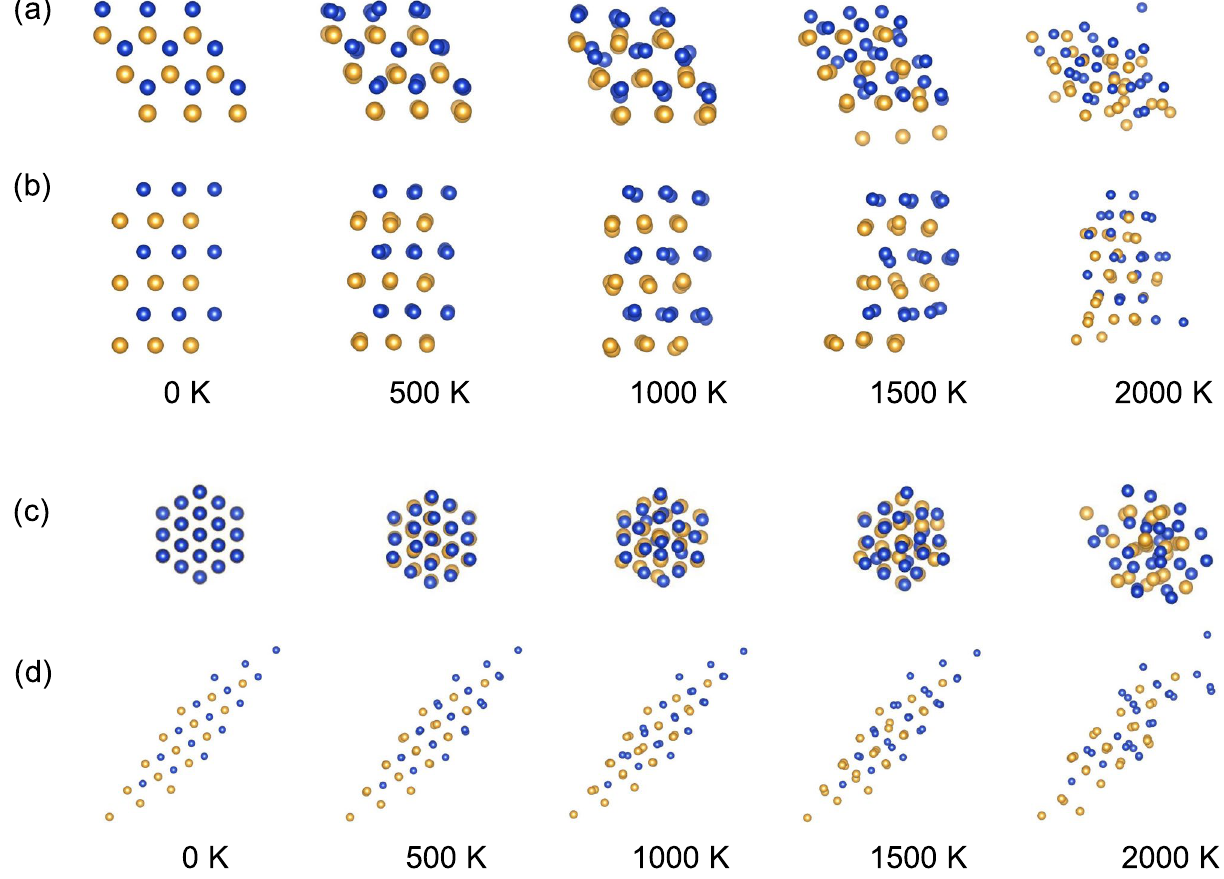
Figure 7. The atomic distribution of the CuAu compounds after the MD simulation of 5 ps (B h ) and 4 ps (L1 1 ) for several T s: ( a ) Top and ( b ) side views of the B h structure and ( c ) top and ( d ) side views of the L1 1